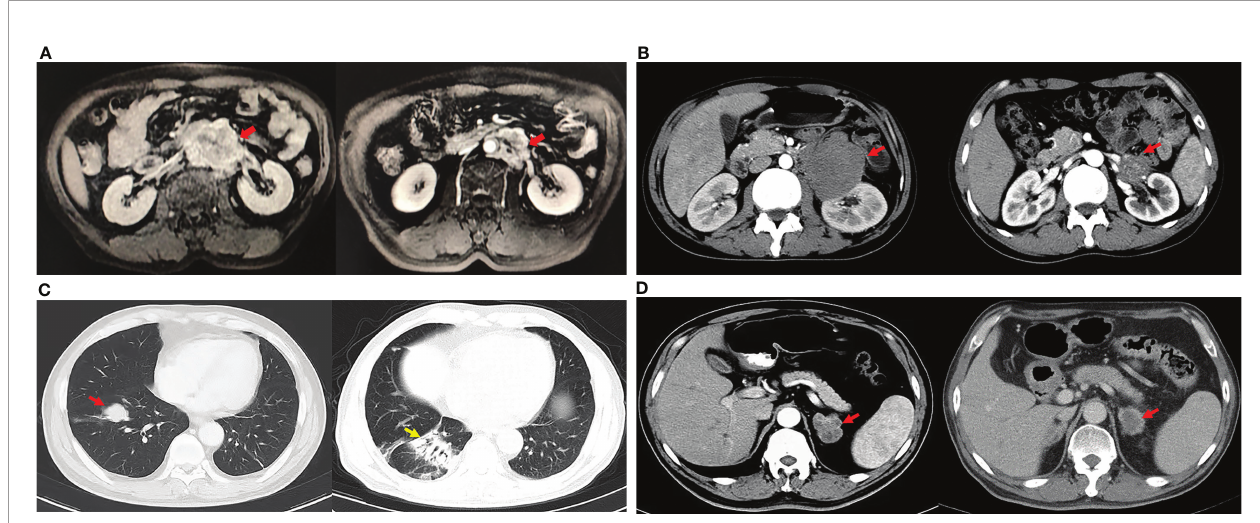
FIGURE 3 | Changes of metastatic lesions during treatments. (A) . PR of the patient after fi rst-line chemotherapy (paclitaxel and cisplatin): the maximum diameter of the retroperitoneal lymph node metastasis (red arrows) decreased from 7.4 cm (left) to 4.4 cm (right). (B) The enhanced CT showed the shrinkage of the retroperitoneal metastasis (red arrows) after sintilimab plus anlotinib. The maximum diameter of the lesion decreased from 8.2 cm (left) to 2.6 cm (right) considering partial response. (C) The enhanced chest CT showed the metastasis located at the right lung (red arrow) disappeared after PD-1 antibody, but interstitial pneumonia appeared (yellow arrow). (D) Meanwhile, the maximum diameter of the left adrenal metastasis (red arrows) decreased from 3.6 cm (left) to 2.8 cm (right) of the same patient described in (C) , so the partial response was